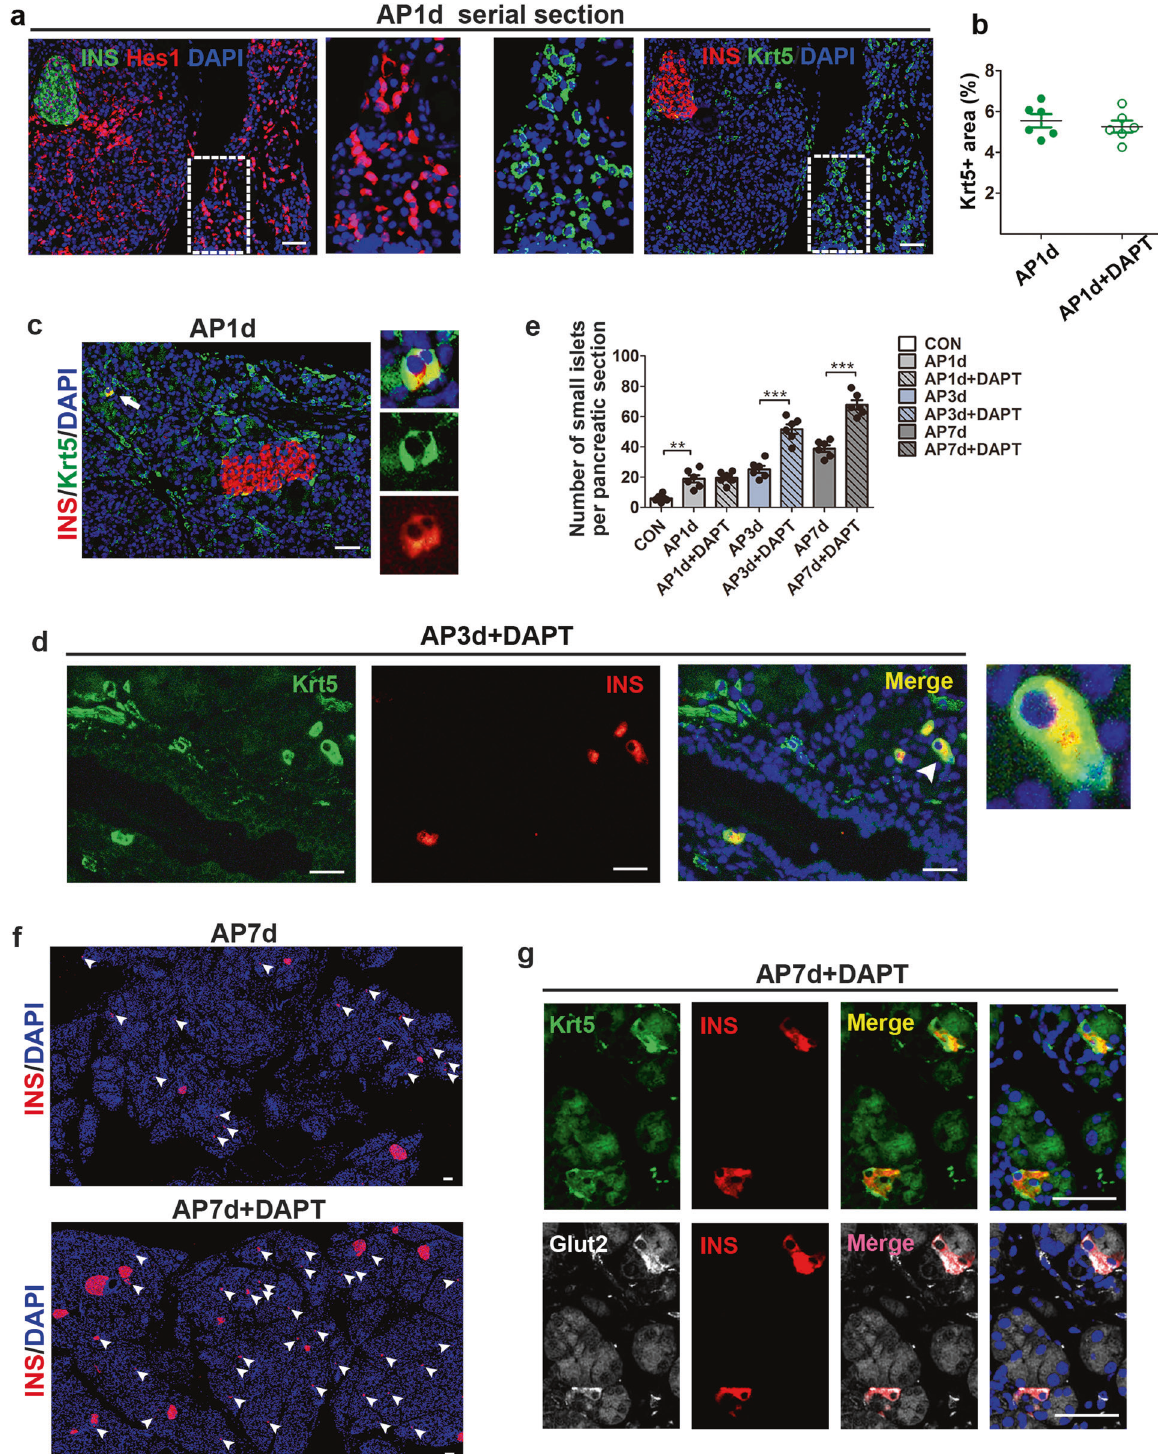
Fig. 6f and Supplementary Fig. 4, signi fi cantly increased numbers of small islets were noted in the DAPT-treated groups. These results, at least in part, explained the improved glucose tolerance of DAPT-treated groups on days 7 and 15 in the AP model. To test whether the newborn small islets were functional, serial sections were used to locate Krt5, insulin and Glut-2 expression. The small islets differentiated from Krt5 + cells were also immunopositive for Glut-2, suggesting that the newborn islets were functional (Fig. 6g).